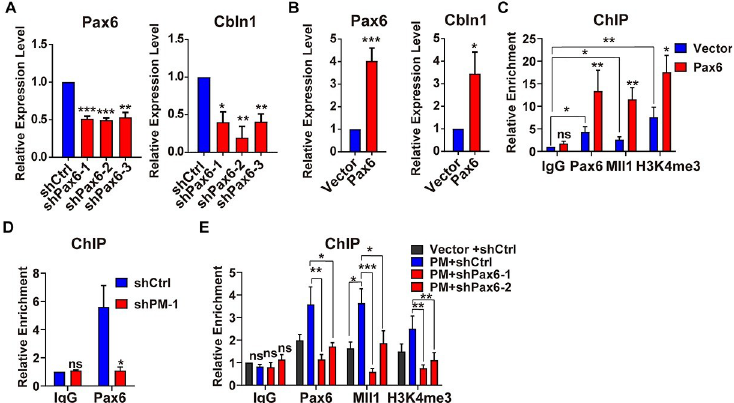
Fig 5. Pax6 is required for the lncRNA-PM -mediated Mll1-H3K4me3 recruitment. (A) The expression levels of Pax6 and Cbln1 mRNAs in the control or Pax6 shRNAs-treated Neuro2a cells. All results were normalized to Gapdh . Data are shown as means ± SEMs, n = 3. (B) The expression levels of Pax6 and Cbln1 mRNAs in the control (Vector) or Pax6 -overexpressed Neuro2a cells. All results were normalized to Gapdh . Data are shown as means ± SEMs, n = 3. (C) ChIP-qPCR detection of the indicated Pax6, Mll1, and H3K4me3 recruitment on the 5 0 regulatory region of Cbln1 in the control or Pax6 -overexpressed Neuro2a cells. Data are shown as means ± SEMs, n = 3. (D) ChIP-qPCR detection of Pax6 on the 5 0 regulatory region of Cbln1 in the control or the indicated sh PM in Neuro2a cells. Data are shown as means ± SEMs, n = 3. (E) Changes of the Pax6, Mll1, and H3K4me3 deposition on the 5 0 regulatory region of Cbln1 in PM -overexpressed Neuro2a cells, with the treatments of Pax6 (shPax6-1 and shPax6-2) or control shRNAs (shCtrl). All the data of this figure can be found in the S1 Data file. Data are shown as means ± SEMs, n = 3. � P < 0.05, �� P < 0.01, and ��� P < 0.001. Cbln1 , Cerebellin-1 ; ChIP-qPCR, chromatin immunoprecipitation couple with quantitative PCR; IgG, immunoglobulin G; lncRNA-PM , lncRNA-Promoting Methylation ; ns, no